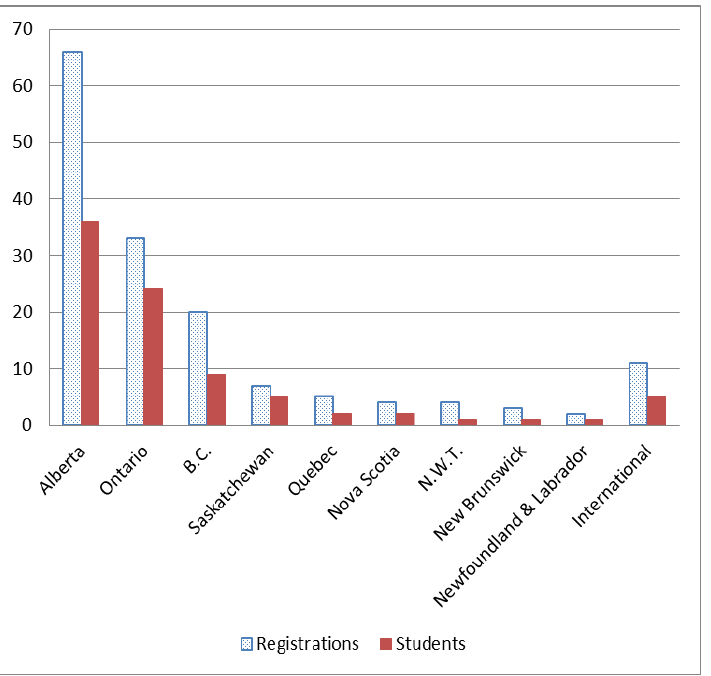
Figure 2 . Geographic distribution of registrations and students. The number of students is always lower than the number of registrations because some students undertake multiple